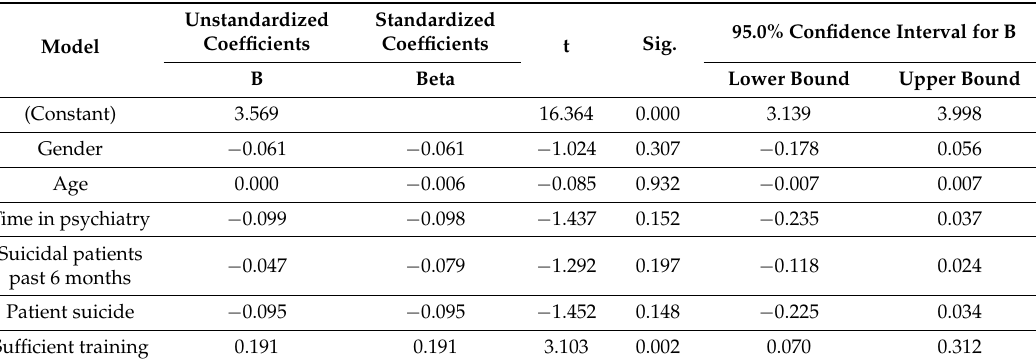
Table 5. Predictors for Attitudes towards prevention